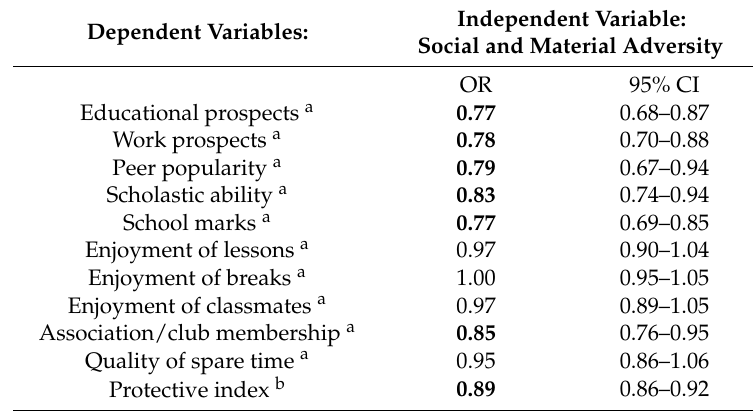
Table 2. Associations between social and material adversity and the protective factors at T1. Results from log-binomial regression analyses, presented as odds ratios per one-unit increase in the measure of social and material adversity ( n = 908). Statistically significant ( p < 0.05) estimates in bold. Adjusted for gender, internalising symptoms, and functional somatic symptoms at baseline. CI = confidence interval; OR = odds